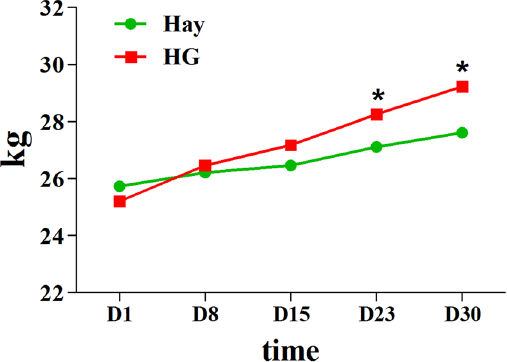
Figure 1. Weight change between hay diet and HG groups. The green and red lines represent the hay and HG groups, respectively; asterisks indicate significant differences between the groups ( p <